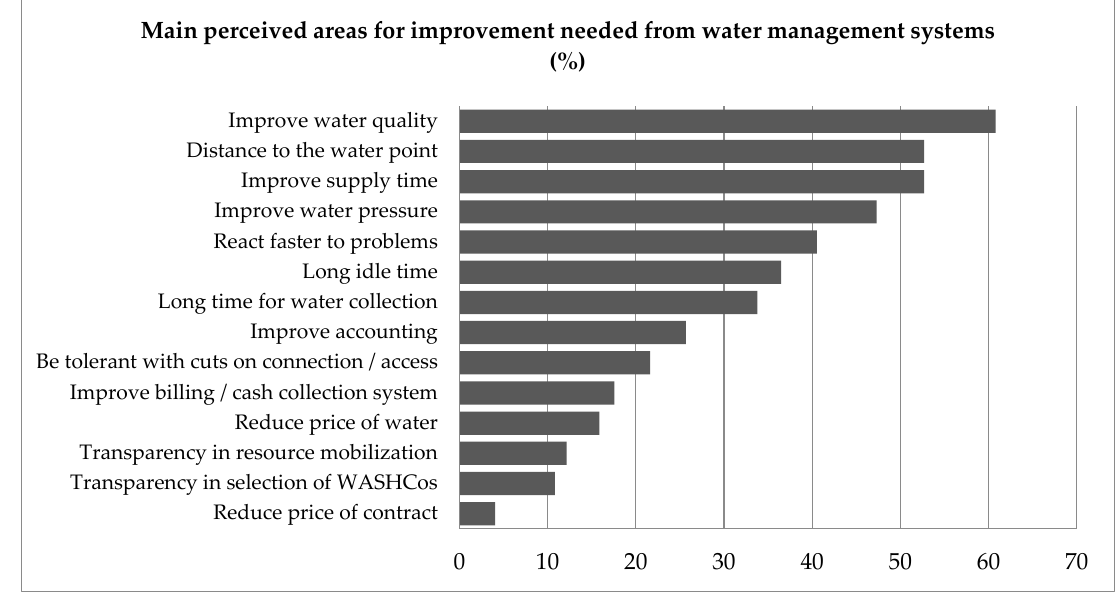
Figure 4. Perceived areas for improvement needed in communities.